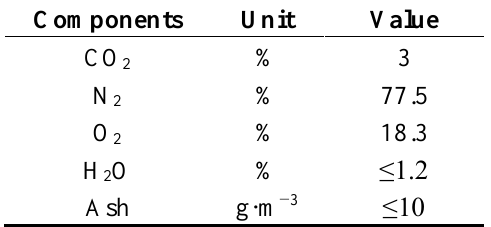
Table 2. Components of the inlet flue gas (on a volume